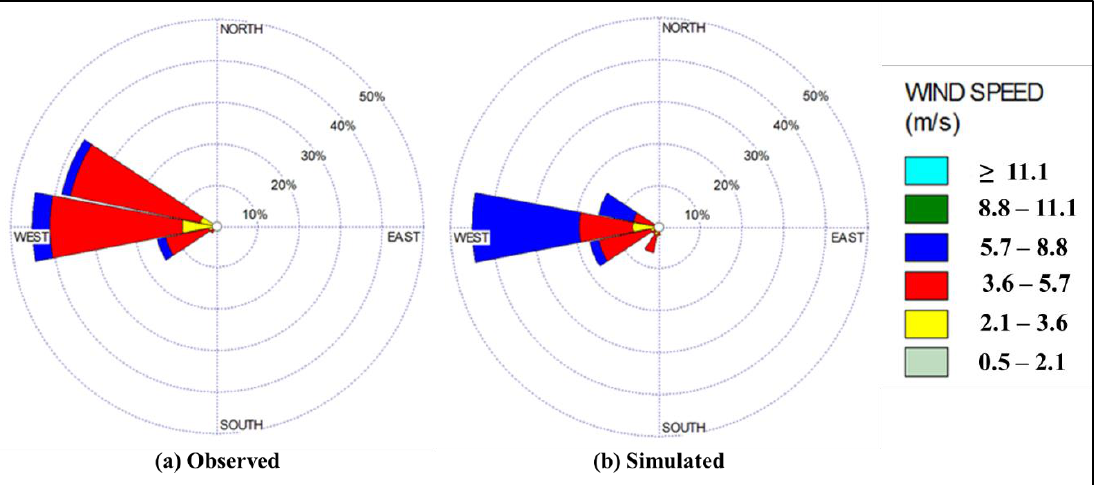
Figure 7. Wind rose plots displaying the wind direction and wind speed for simulated period over Delhi. ( a ) Observed, ( b ) simulated.